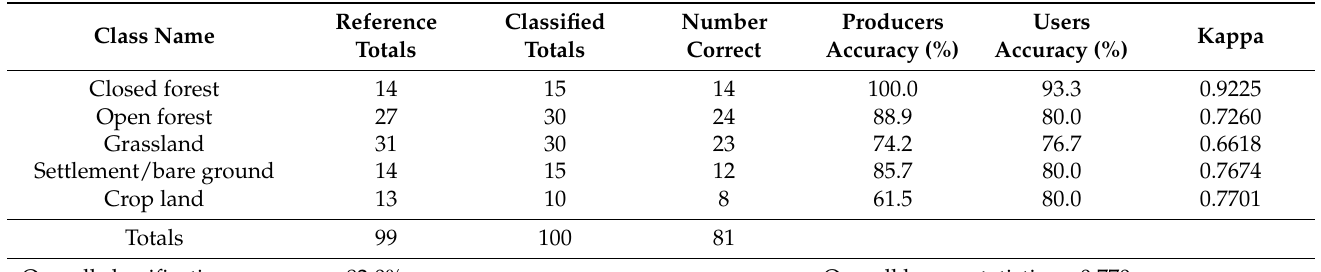
Table 9. Accuracy assessment of the various land use types in the Bobiri forest reserve, Ghana.